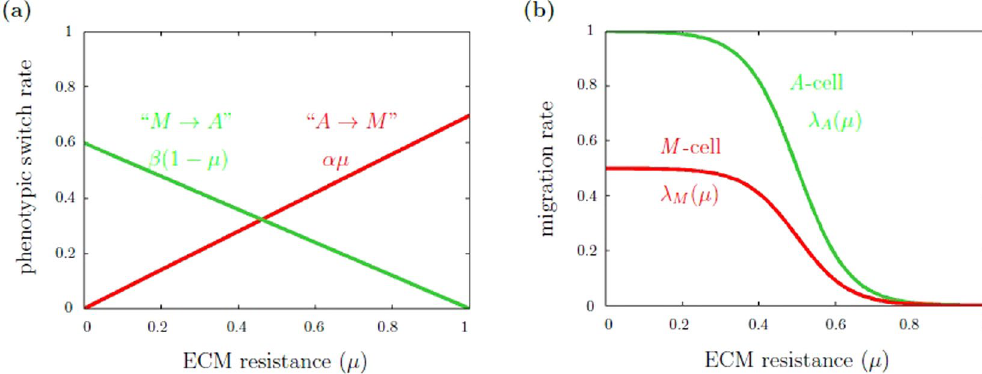
Figure 1. Phenotypic switch rates and migration rates as functions of ECM resistance. ( a ) Phenotypic switch rate. A -cells change their phenotype with rate αμ and M -cells with rate β μ − (1 ) . In the plot, the switch parameters are α = 0.7 and β = 0.6. ( b ) Migration rate. For A -cells, the migration rate is given by equation (3a), for M -cells by equation (3b). Parameters are the migration rate constants c A and c M , which are chosen c A = 1 and c M = 0.5 in the plot.